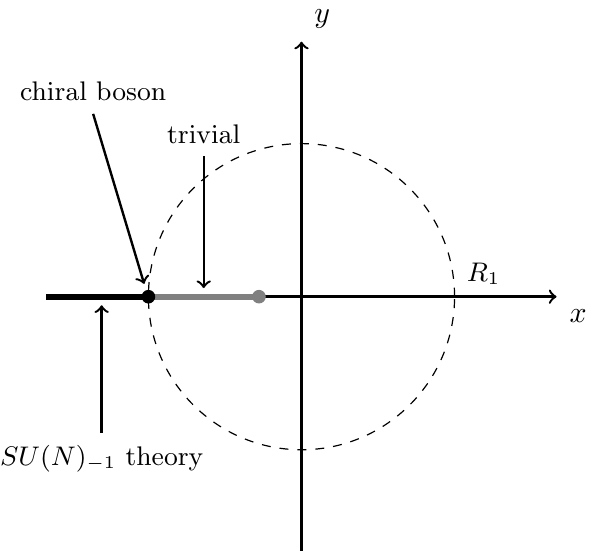
Figure 2: The dynamics in the interior for a space-dependent mass profile = 1. The interface extends along the negative x axis and m = (cid:34) re i α Λ 2 when N f terminates at some point. At radius R , the theory on the interface goes through 1 a transition from an SU ( N ) − Chern-Simons theory to a trivially gapped theory. It 1 leads to a 1 + 1 dimensional compact chiral boson localized at the transition